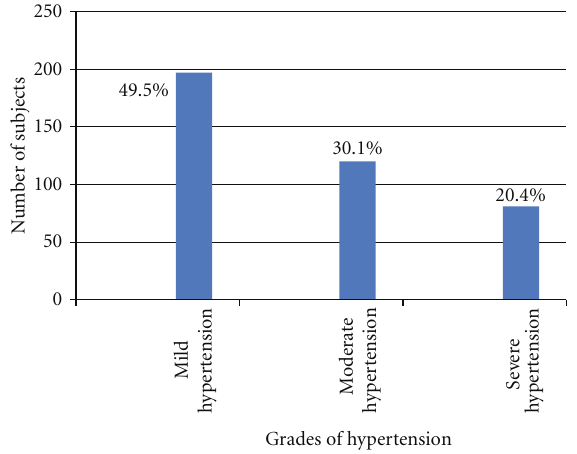
Figure 3: Grades of hypertension among the hypertensive subjects (% representation was inserted).